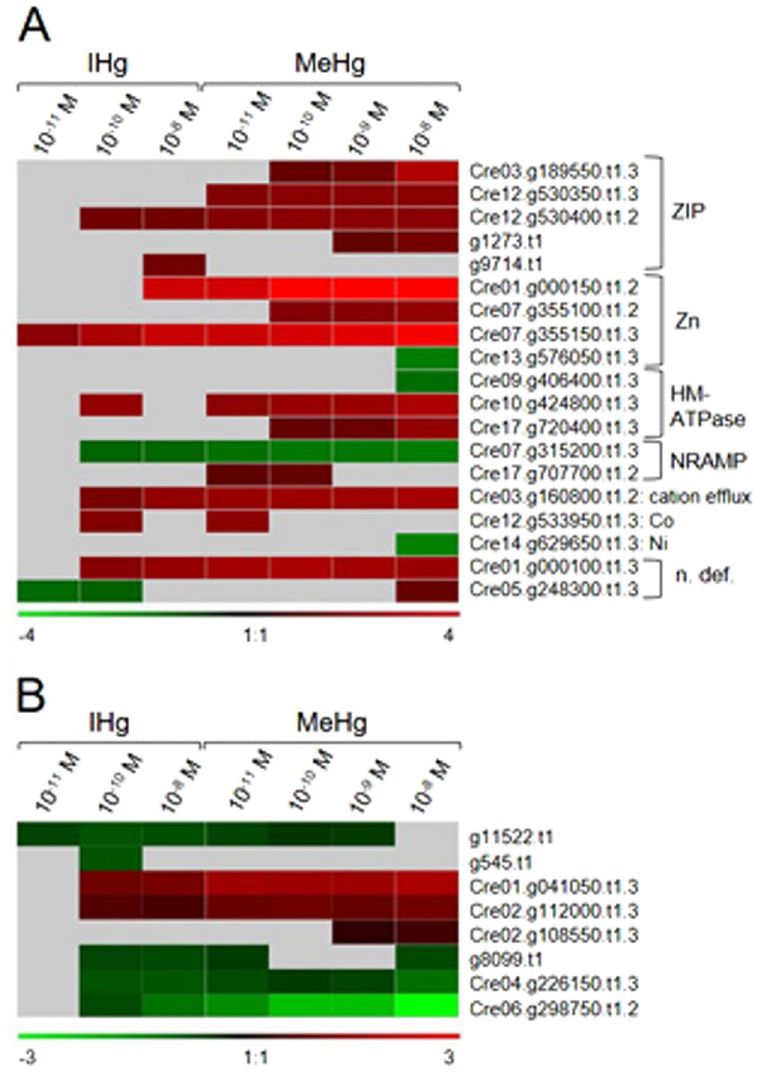
Figure 3. Gene expression regulation of 19 metal ( A ) and 8 amino acid ( B ) transporters significantly dysregulated in C. reinhardtii exposed 2 h to IHg or MeHg (ZIP = zinc-, iron-regulated transporter family; Zn = zinc transporter precursors; HM-ATPase = heavy metal ATPase; NRAMP = natural resistance-associated macrophage protein metal ion transporter family protein; Co = cobalt ion transmembrane transporter; Ni = high-affinity nickel-transport family protein; n. def. = no definition) (Phytozome